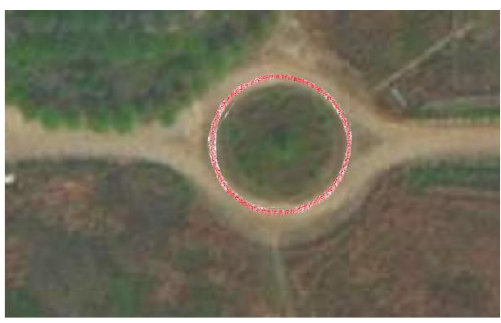
Figure 12. Experimental environment.